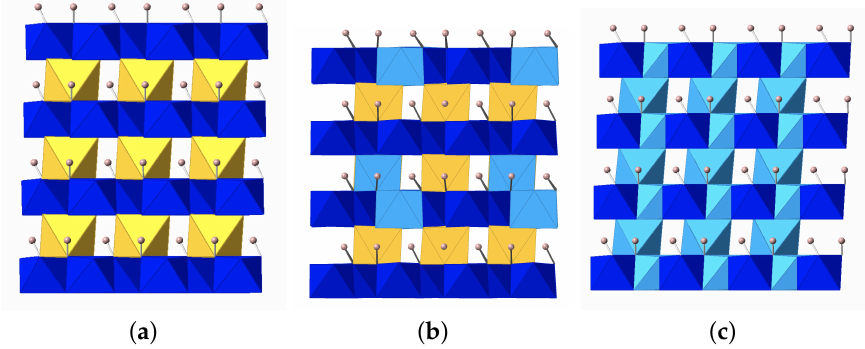
Figure 1. Relaxed crystal structures of phase D with composition ( a ) MgSi 2 O 6 H 2 , ( b ) Mg 5 Al 6 Si 13 O 48 H 16 , and ( c ) Al 2 SiO 6 H 2 at 20 GPa viewed normal to the (011) plane, in which MgO 6 units are yellow, SiO 6 units are dark blue, and AlO 6 units are light blue. H is pink, with OH bonds marked where bond lengths are less than